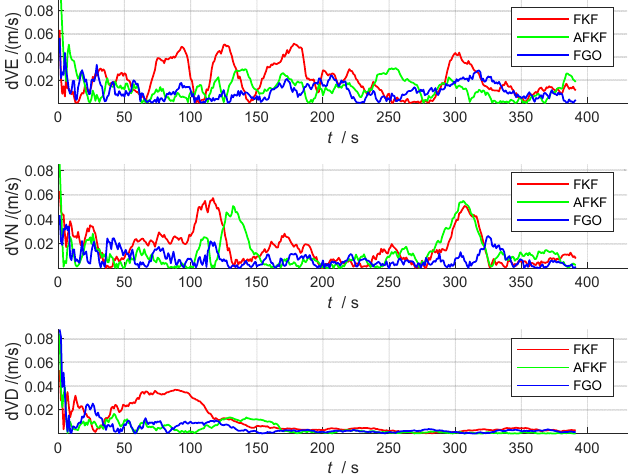
Figure 9. Comparison of speed errors of different algorithms.